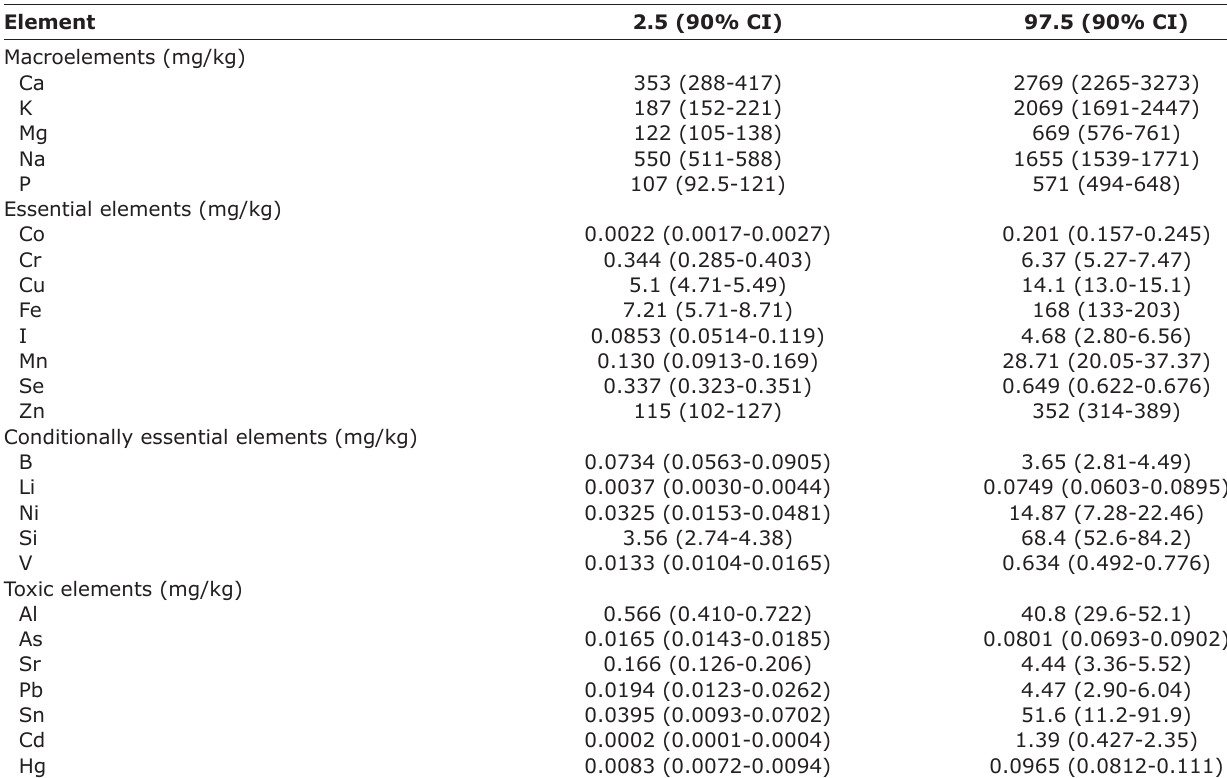
Table-6: Reference ranges of concentrations of essential and toxic elements in laying hens at the age of 140-230 days. Element